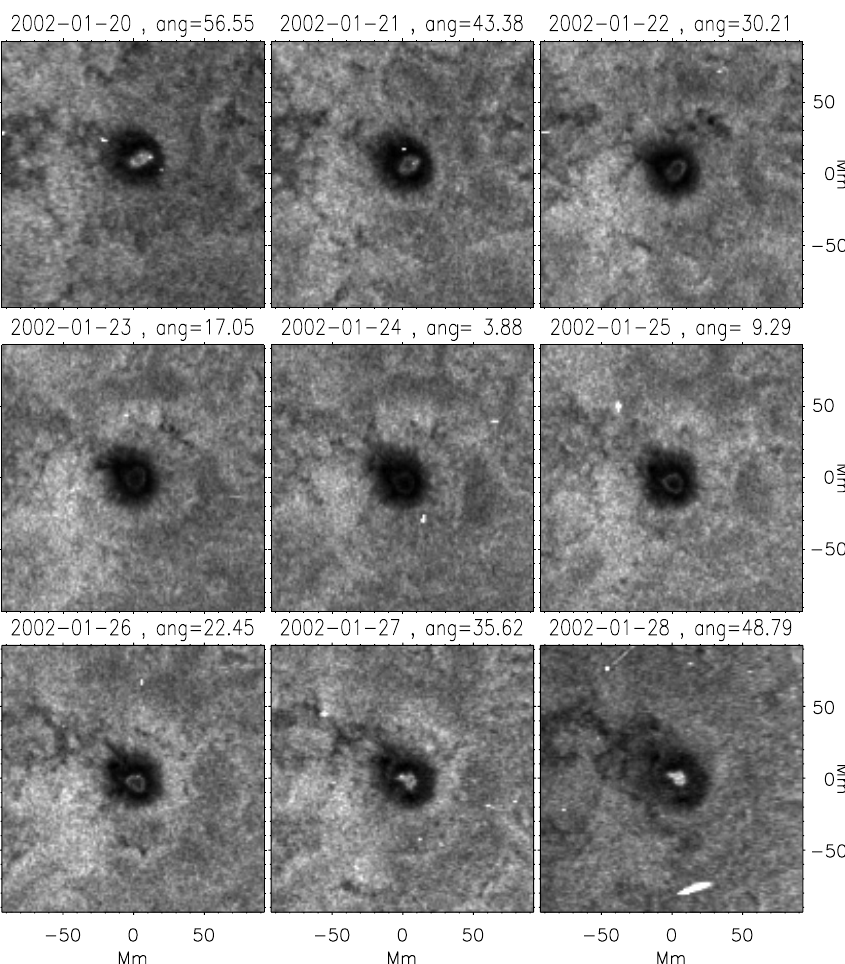
Fig. 2. As Fig. 1 but for the frequency band centred 6mHz. The images show a significant variation dependent on the heliographic angle and reveal easily noticeable power enhancement inside the sunspot at large angles from the solar disk centre (first and last frames of the panel).